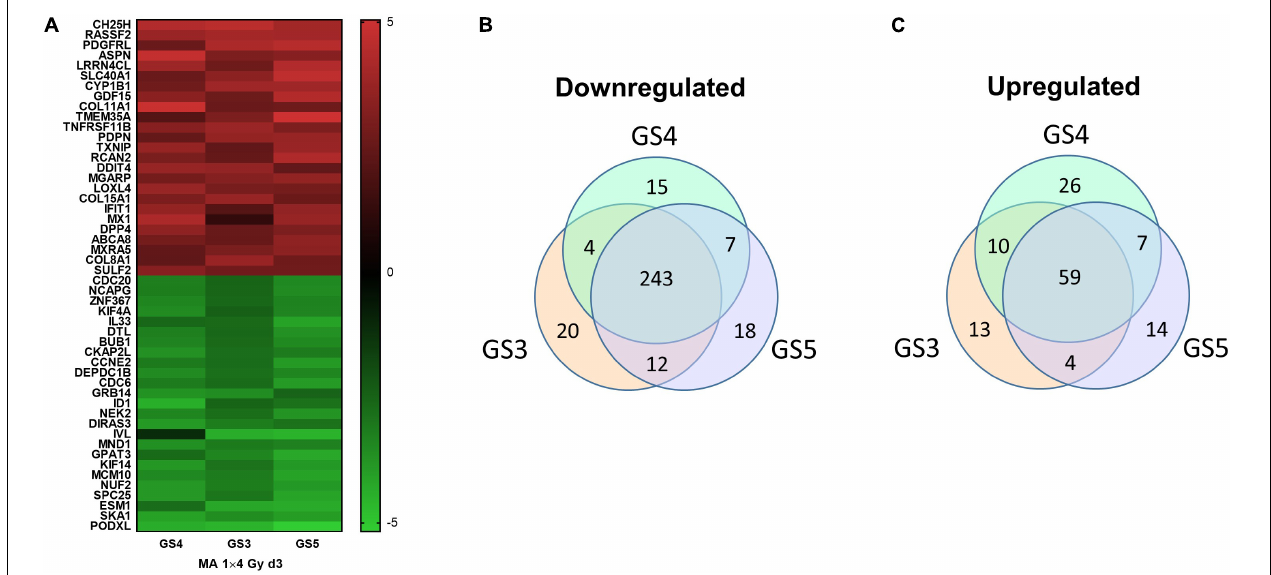
FIGURE 5 | Heat map of top25 up- and downregulated genes in the three fibroblast strains (GS3-5) on day 3 in microarray experiments #3–5 (A) . Venn diagrams for pathways upregulated (B) or downregulated (C) on day 3 after a single dose of 4 Gy to the three fibroblast strains GS3, GS4, and